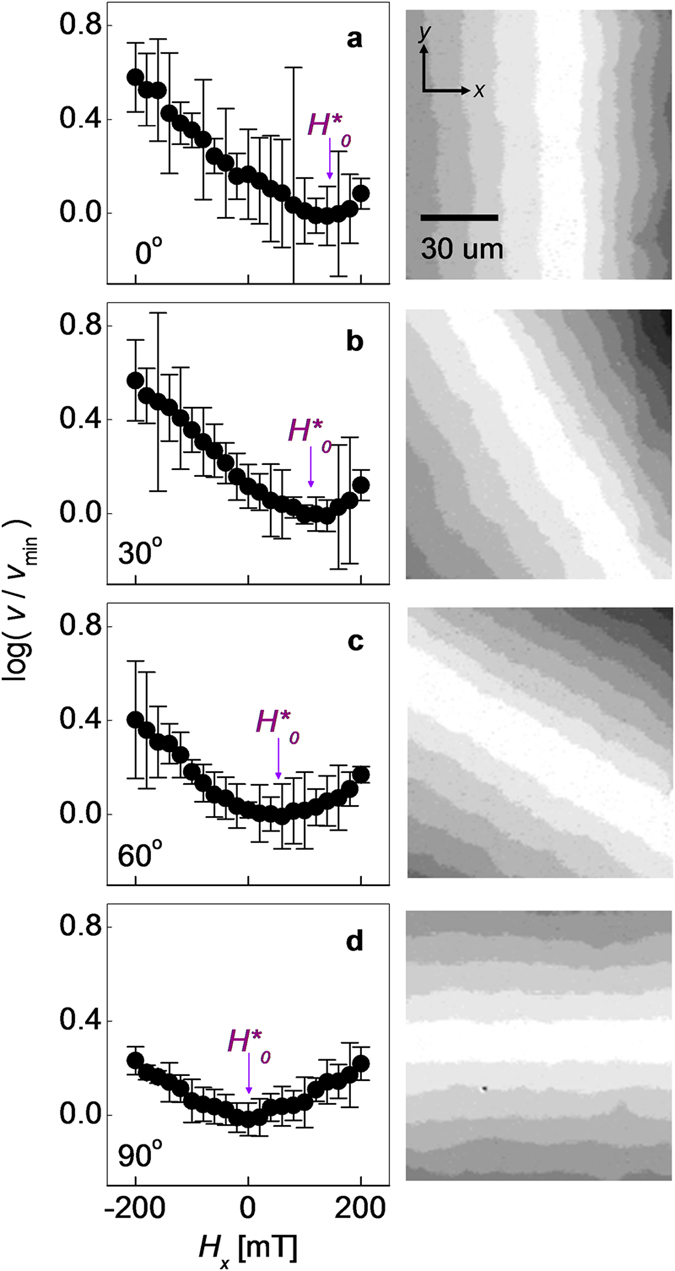
Plot of v/vmin as a function of Hx in a Pt/Co/AlOx film, for fixed Hz = 5.5 mT and under various values of θ.(a) 0° (b) 30° (c) 60°, and (d) 90°. The displacement of the DWs at each angle is driven by the external magnetic fields.